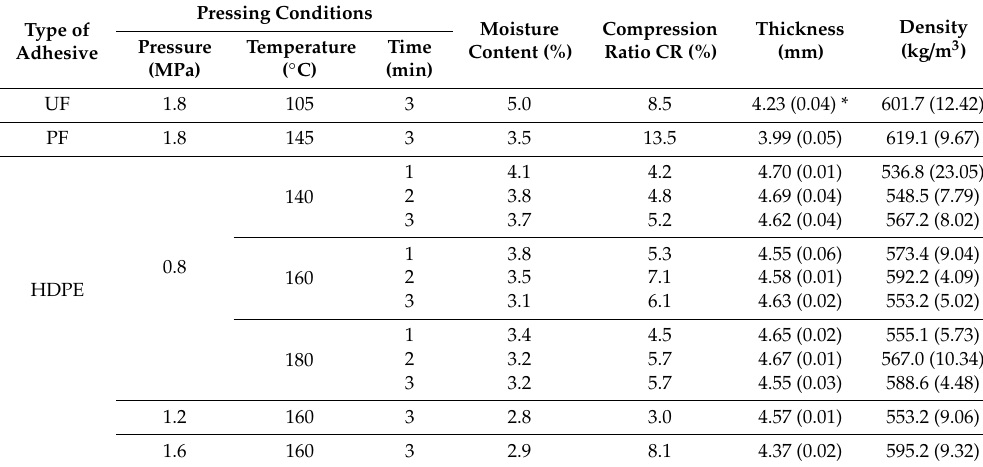
Table 4. Thickness and density of plywood